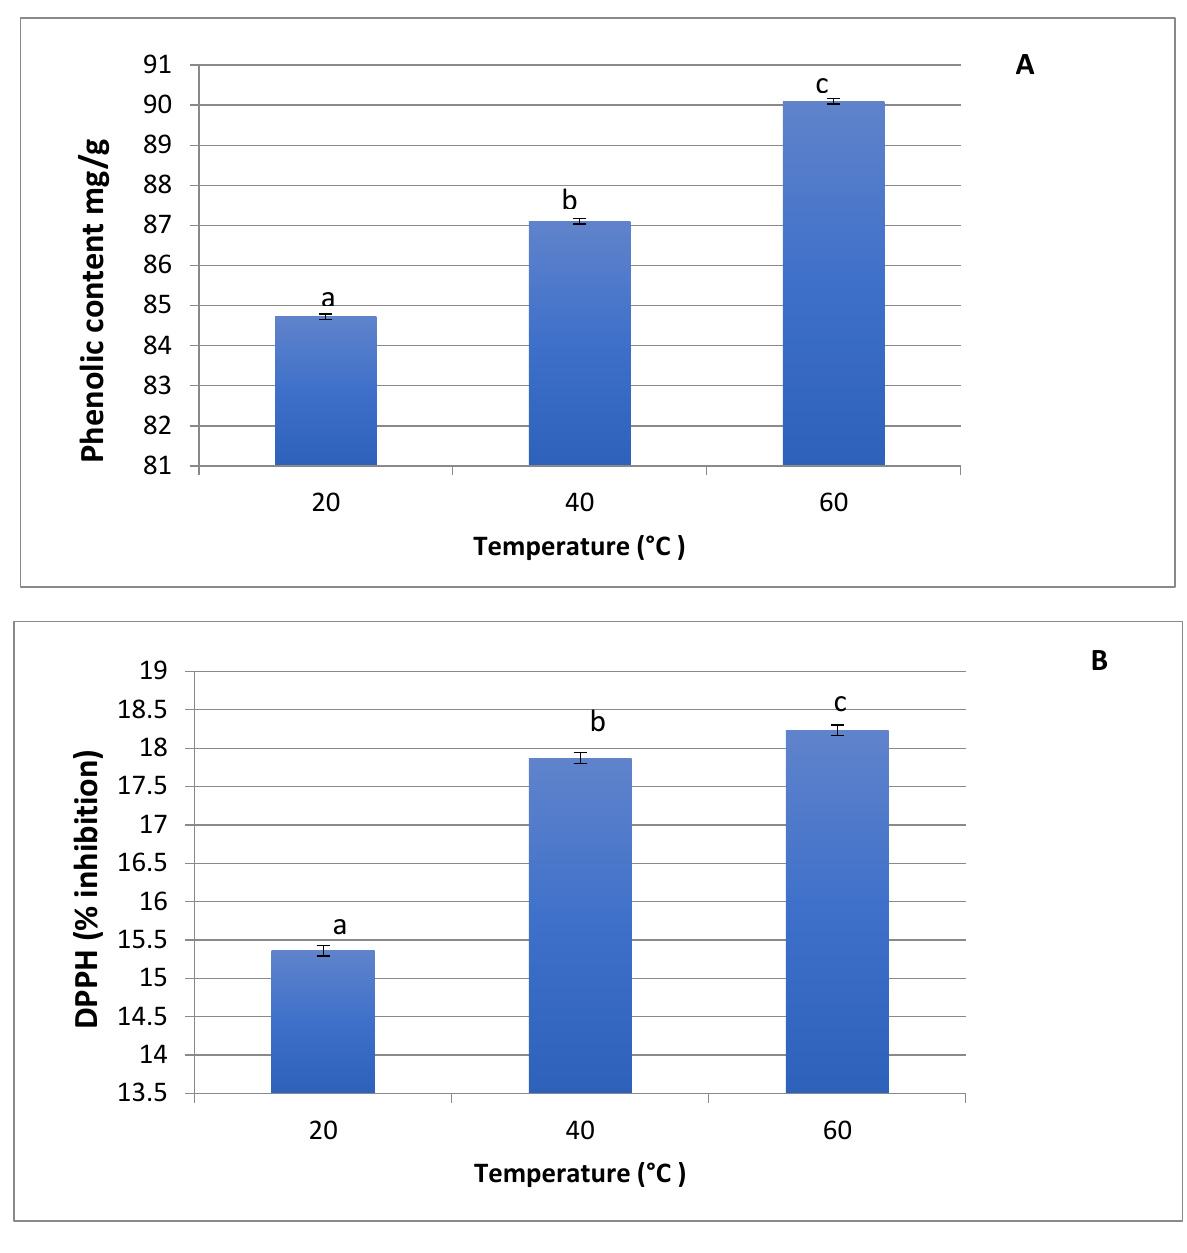
Figure 1. ( A ) The total phenolic content and ( B ) antioxidant activity of rosemary plant extracts (a–c denotes means with same letters are not statistically significant p >